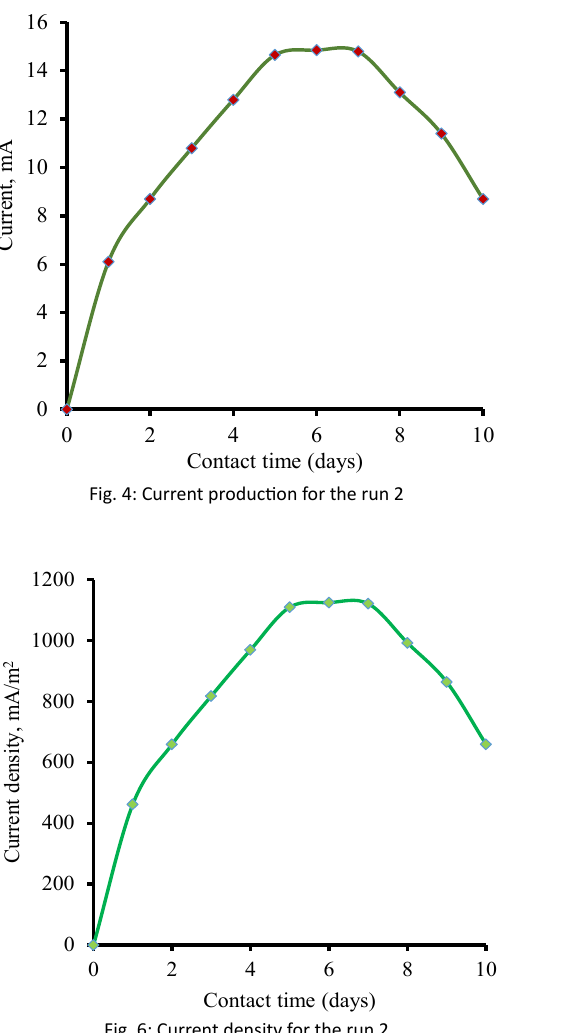
Fig. 6: Current density for the run 2 Fig. 7: Power density for the run 2